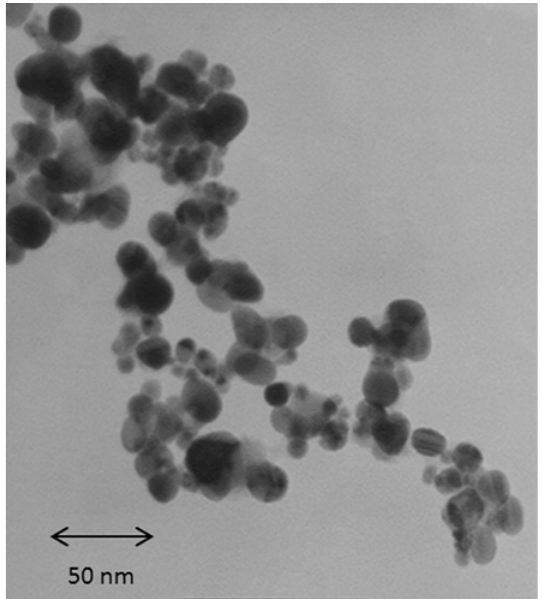
Figure 7: TEM image of the synthesized AgNPs at obtained optimum conditions.